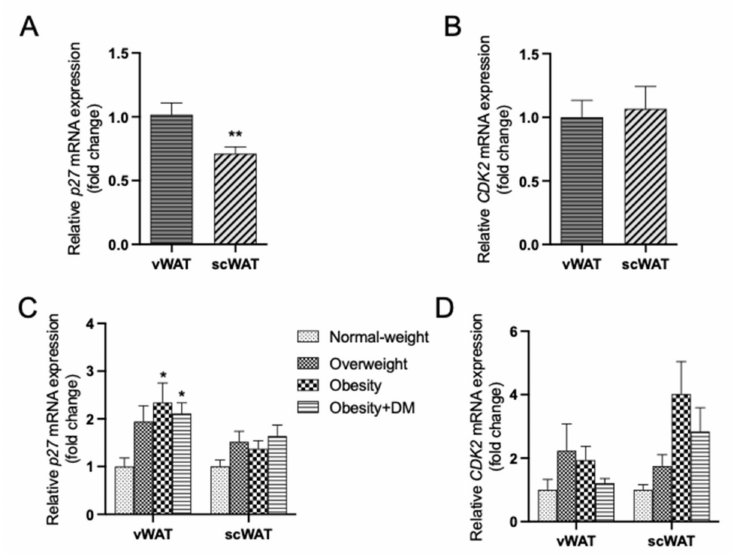
Figure 5. ( A , B ): Differential mRNA expression of p27 and CDK2 in human vWAT vs. scWAT. Data (mean ± SEM) are expressed as fold change of vWAT considered as 1. ** p < 0.01 vs. vWAT. ( C , D ). Effects of overweight and obesity with or without type 2 DM on the mRNA expression of p27 ( C ) and CDK2 ( D ) in human vWAT and scWAT. Data (mean ± SEM) are expressed as fold change of normal-weight group, considered as 1. * p < 0.05, vs. normal-weight.